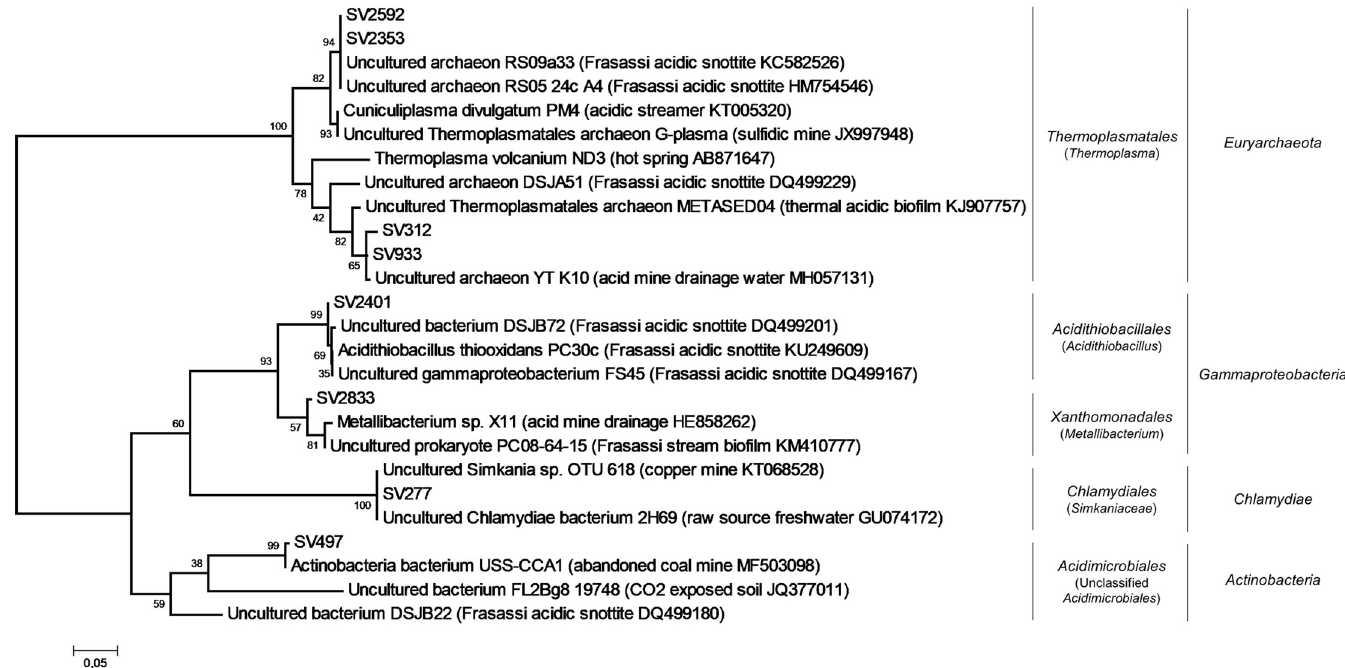
Fig 13. Phylogenetic tree of the most abundant SVs in gypsum moonmilk in Fetida Cave. For taxonomy details and Best Blast Hit of the SVs reported, see S8 Table.